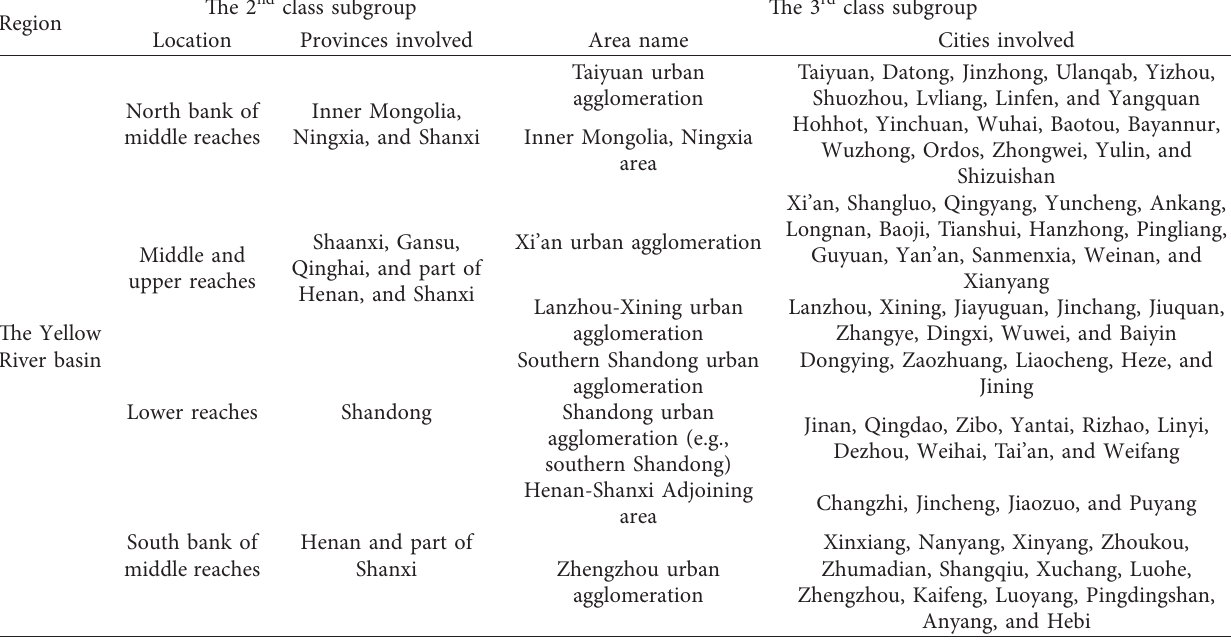
Table 5: Analysis table of cohesive subgroups of city networks in the Yellow River basin.